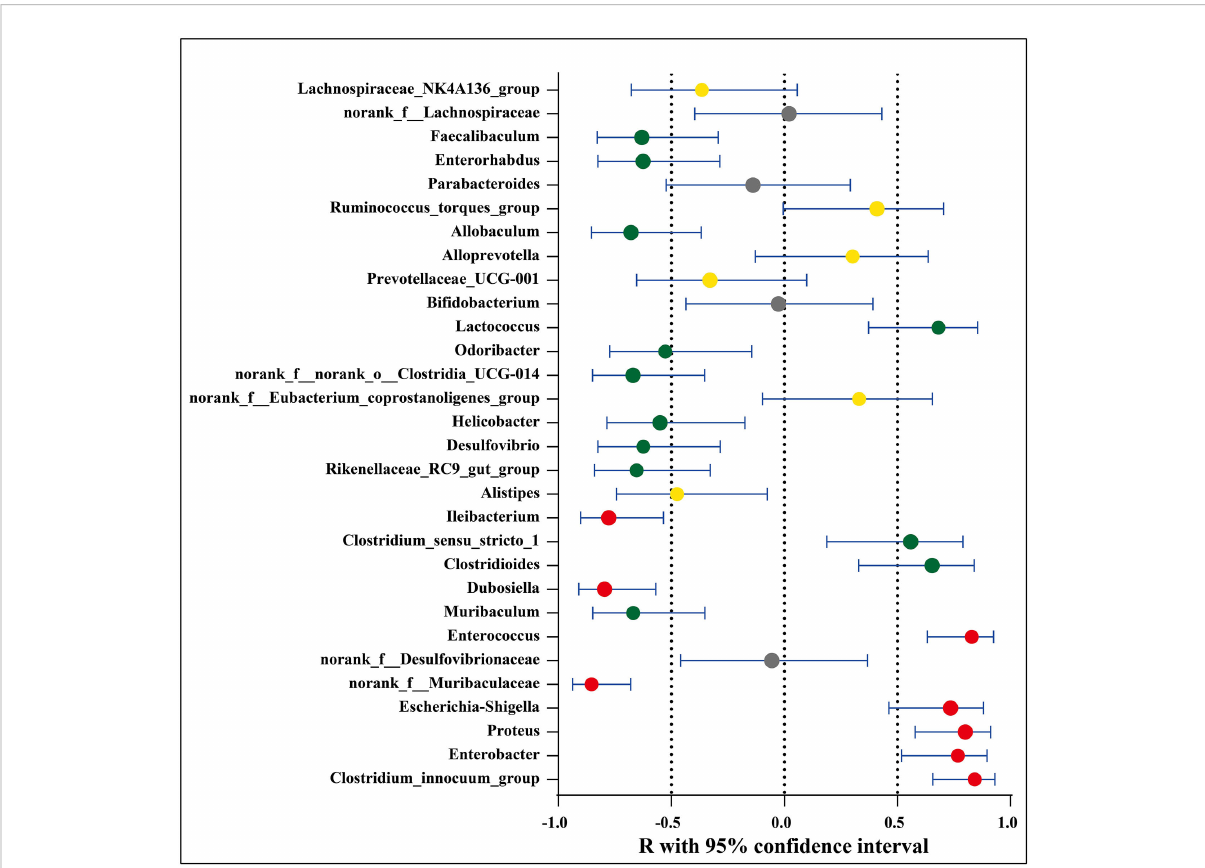
FIGURE 4 Association between signi fi cantly increased or decreased microbial genera/OTUs in EAE groups and corresponding neurologic function scores. Red dots represent a strong correlation (0.7 ≤ R < 1), green dots represent a moderate correlation (0.5 ≤ R < 0.7), yellow dots represent a weak correlation (0.3 ≤ R < 0.5), and gray dots represent a poor correlation (0 < R < 0.3). The relation between the abundance of microbial genera/ OTUs and the neurologic function scores were performed using Spearman ’ s rank correlation coef fi